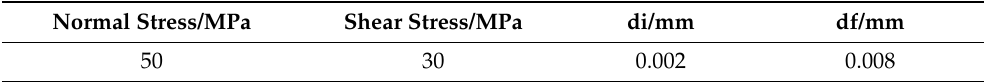
Figure 14. Constitutive model of structural adhesive cohesion. Table 2. Adhesive Table 2. Adhesive parameters.